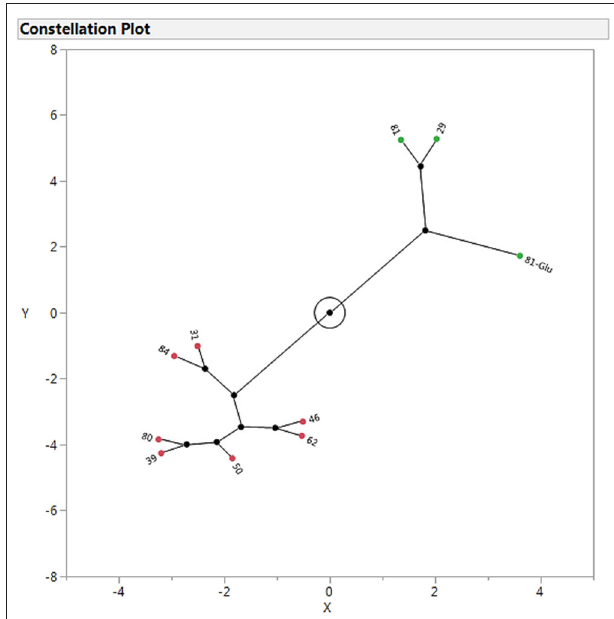
FIGURE 6 | Castellation plot showing two clusters of E. muricata from Arkansas, USA based on germination capacity. The accessions were grown in a common garden in Fayetteville, Arkansas. Seeds were after-ripened for 180 d at 25 ◦ C and germinated in a growth chamber at 32 ◦ C day/23 ◦ C night temperature with 12-h photoperiod. Cluster 1 = Red; Cluster 2 = green.